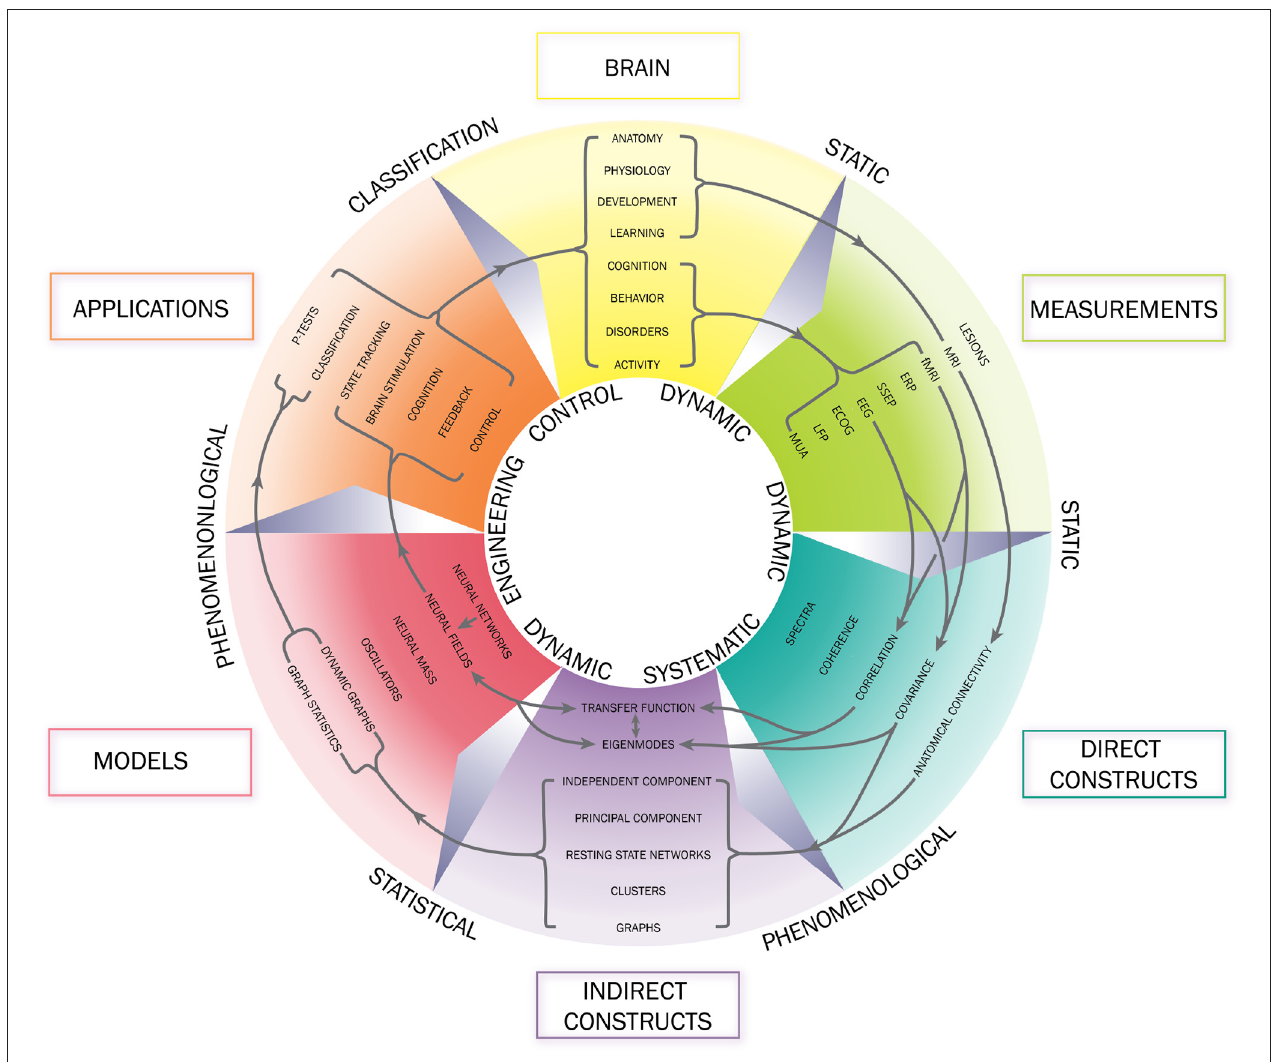
FIGURE 5 | Schematic of some of the relationships of brain data, analyses, and applications. Clockwise from the top, categories of brain observables are shown, followed by measurements, direct and indirect data analyses, resulting models, and applications. In general, smaller radii refer to more dynamic and physical aspects, while larger radii relate to more static and phenomenological aspects. (Of course, some physical aspects are static and some dynamical analyses are phenomenological.) Arrows show a subset of the relationships used in the